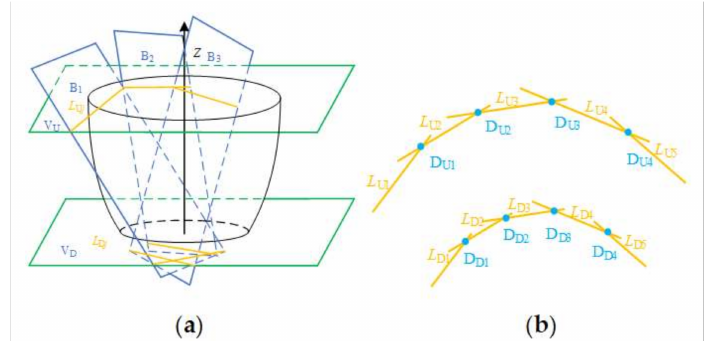
Figure 8. Intersection of the cutting surface and the rotating surface: ( a ) upper and lower cutting lines; ( b ) upper and lower cutting points.